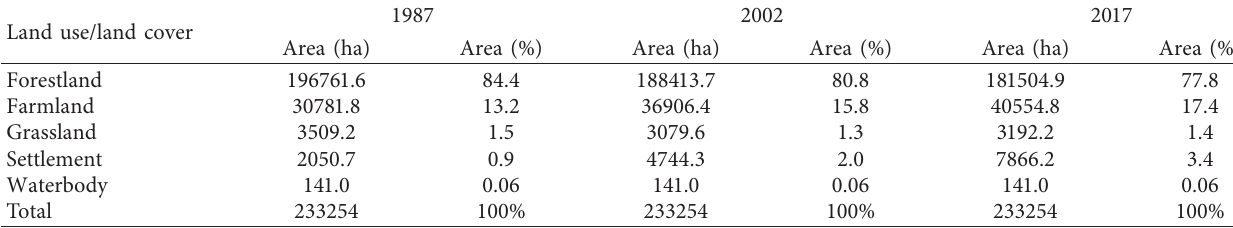
Table 5: Area of LULC class from 1987 to 2017 periods in